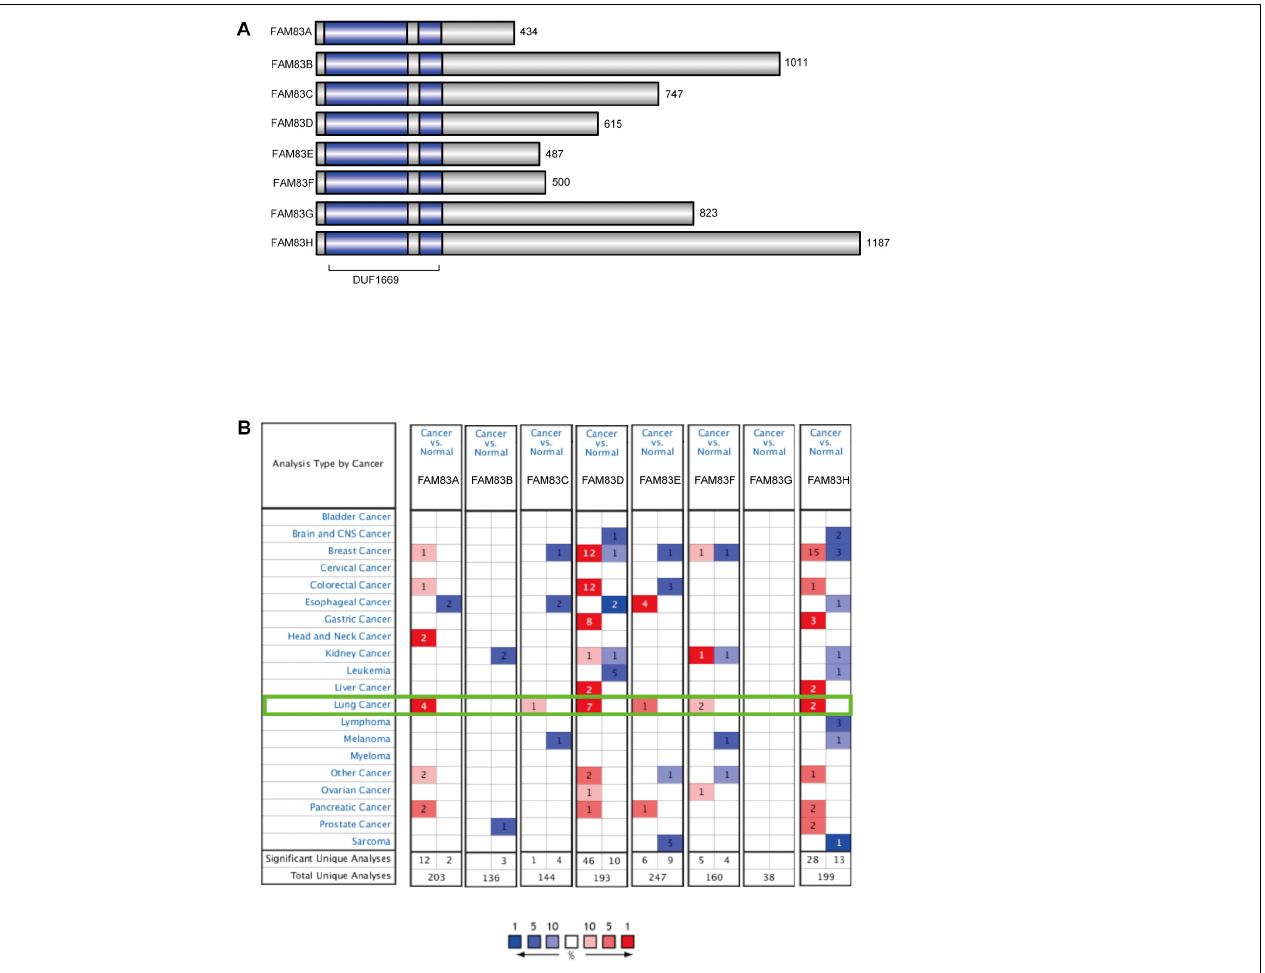
FIGURE 1 | The expression of FAM83 family in distinct types of cancer diseases (ONCOMINE database). (A) The pattern diagram of the human FAM83 family of proteins and the conserved domain of unknown function, DUF1669 that characterizes them. (B) The figure shows the numbers of datasets with statistically significant mRNA up-regulation (red) or down-regulated expression (blue) of FAM83 family. Student’s t -test was used to compared the different transcriptional. Cutoff of p -value and fold change were as following: p -value: 0.01, fold change: 2, gene rank: 10%, data type: